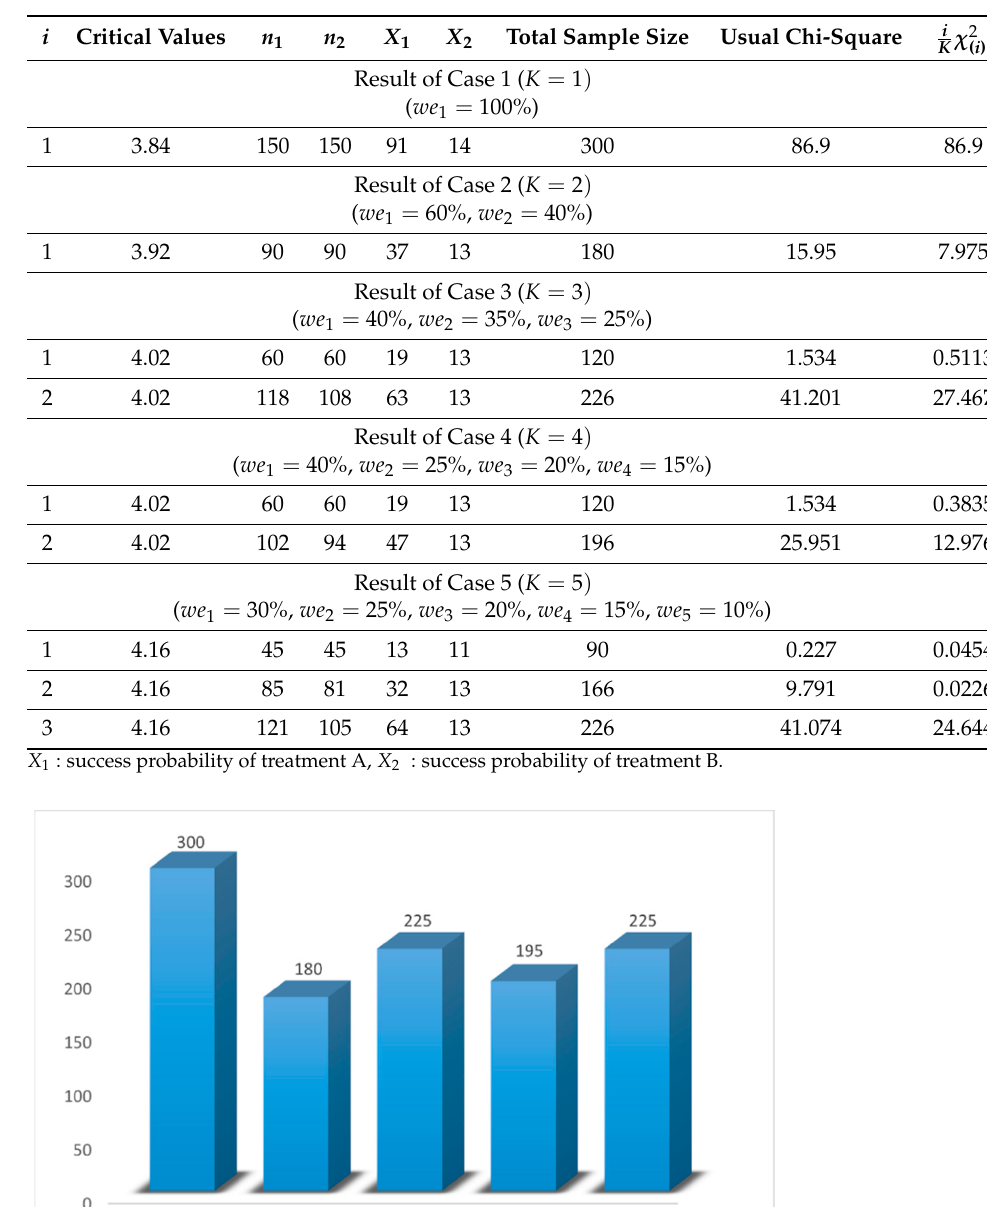
0 for the real-life